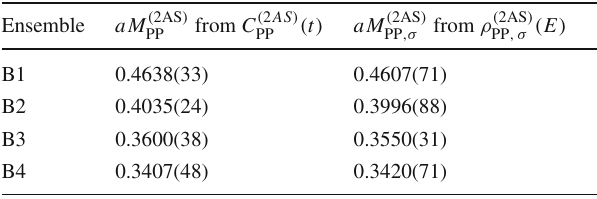
Table 3 Predictions for the pseudoscalar mass in the 2AS sector from different ensembles. The values are depicted in Fig.14 ( 2AS ) Ensemble aM PP